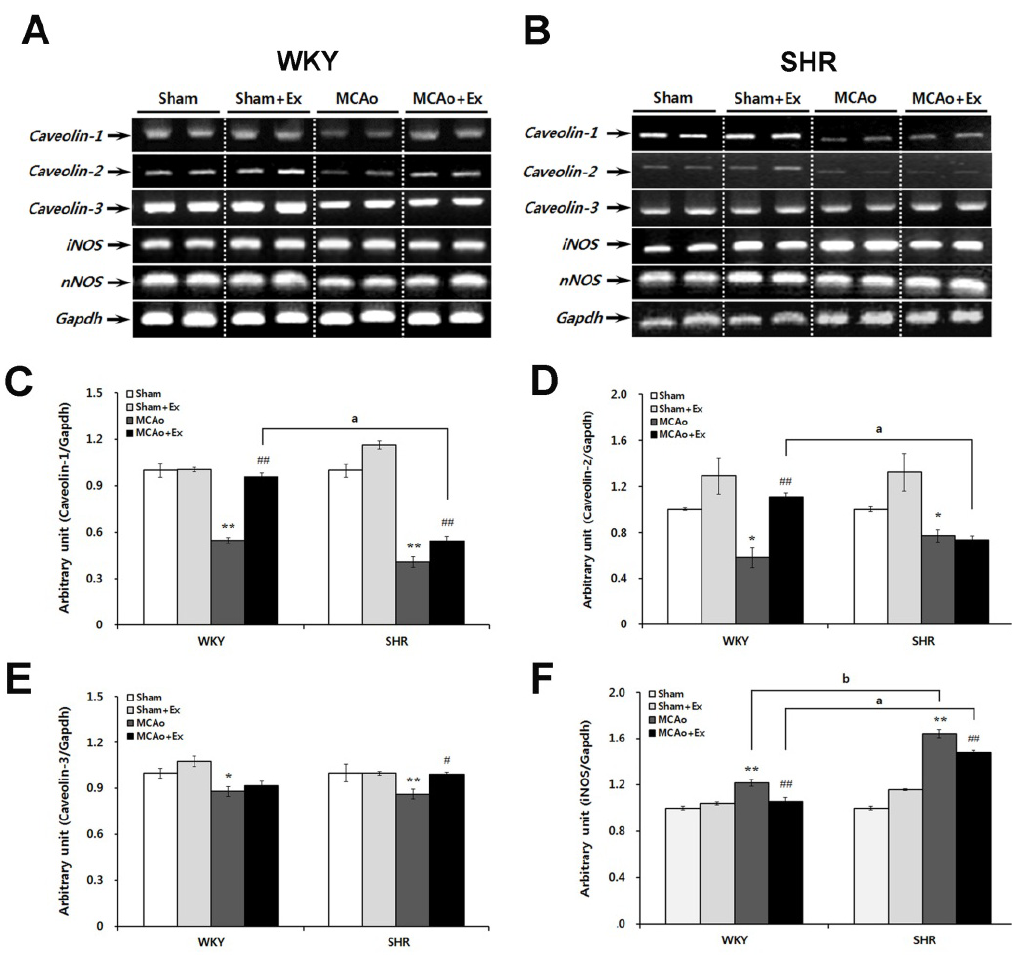
Figure 4. Altered expression of caveolins and NOS isoforms in WKY and SHR rats after MCAo surgery. ( A ) Electrophoresis of caveolin-1, -2, -3, nNOS, and iNOS in brain tissue of WKY rats and ( B ) SHR rats with MCAo surgery. ( C ) Expression of caveolin-1 mRNA in the MCAo group was significantly decreased compared with that in the sham group in WKY and SHR rats. Also, caveolin-1 mRNA was increased in SHR rats after the treadmill exercise. ( D ) Caveolin-2 mRNA levels were increased in the MCAo + Ex group in WKY rats after exercise. ( E ) Caveolin-3 mRNA was decreased in the MCAo group in WKY rats, and it increased after exercise. ( F ) Expression of iNOS mRNA was increased in the MCAo group of WKY and SHR rats. ( G ) Expression of nNOS mRNA in the MCAo groups of WKY and SHR rats was decreased. Data shown are means ± SEM. ** p < 0.01, compared with sham group; # p < 0.05, ## p < 0.01 compared with MCAo group; a p < 0.01 between MCAo + Ex WKY and SHR groups; b p < 0.01 between WKY and SHR MCAo